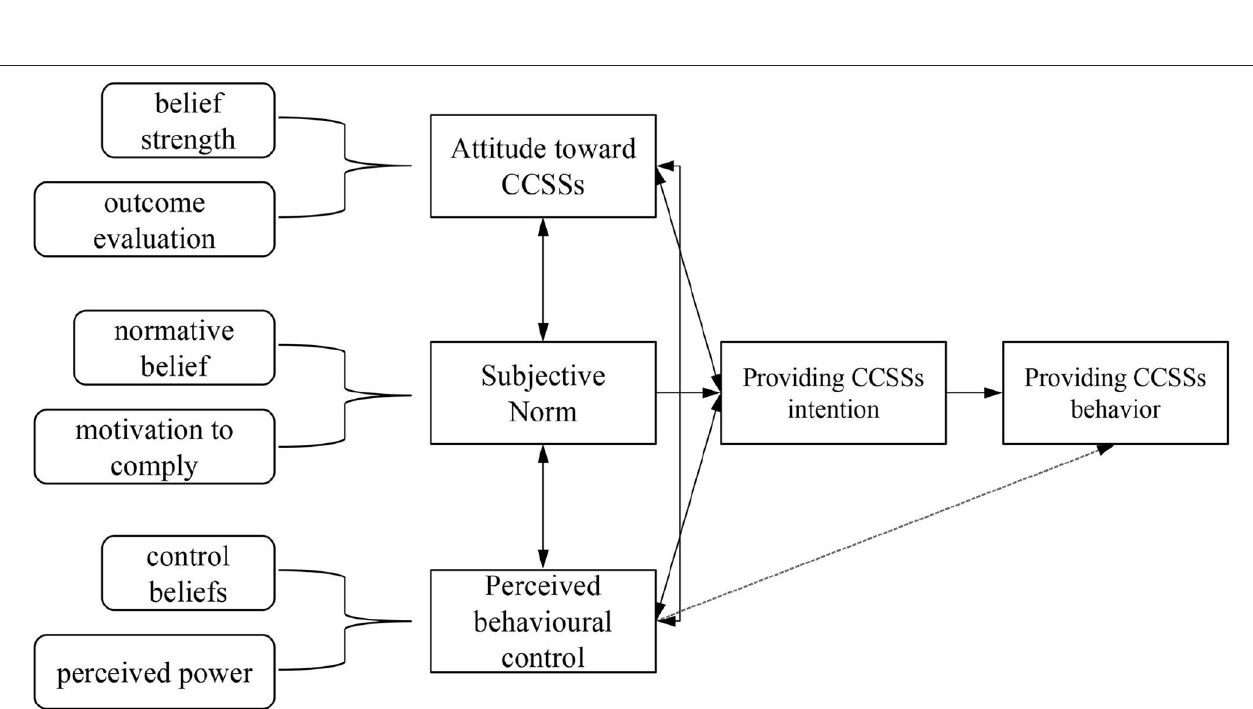
FIGURE 2 | A Structural model of the theory of planned